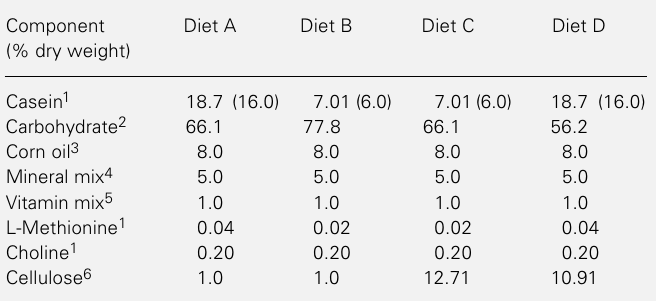
Table 1 - Protein carbohydrate and cellulose content (%) of diets offered to dams during lactation. Banana extract was administered as 1% of each formulation. 1 Dyets Inc., USA (high nitrogen casein, 85.55%); 2 maize starch (Maizena fi ); 3 Mazola fi ; 4 AIN 76, American Institute of Nutrition Rodent Diets 1976 (Ref. 3); 5 AOAC, Association of Official Agricultural Chemists 1960 (Ref. 4); 6 Carboxyl Methyl Cellulose fi